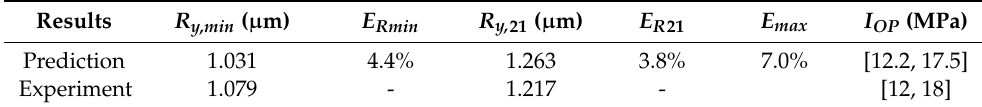
Table 3. Prediction results of LPBed Inconel 718 and accuracy